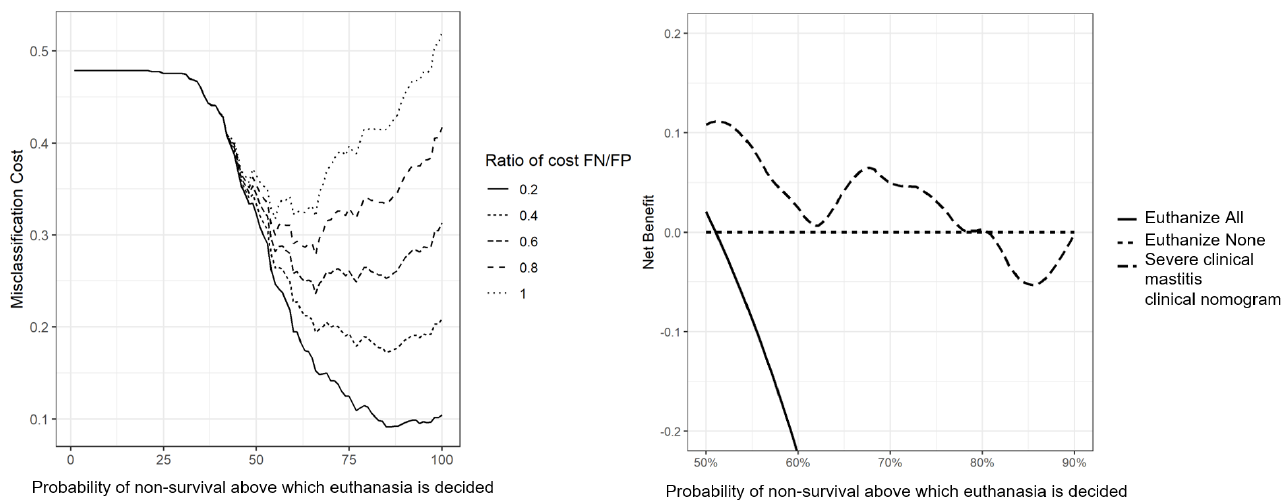
Figure 7. Decision curve analysis (left graph) and misclassification cost term (right graph) of a nomogram built with predictors from the clinical exam, predicting survival of dairy cows coming from 124 herds in Québec, Canada with severe clinical mastitis in the 60-day period following a veterinary clinical evaluation. (FN: False negative; FP: False Positive).